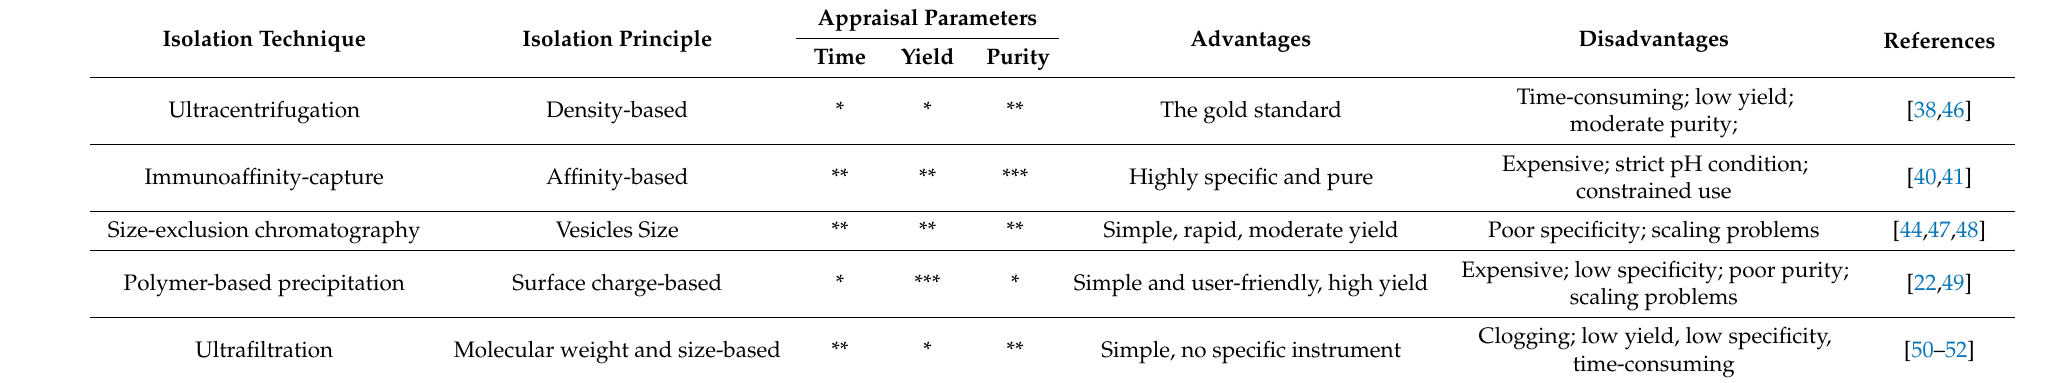
Table 1. Summary of a comparative study of existing conventional exosome isolation